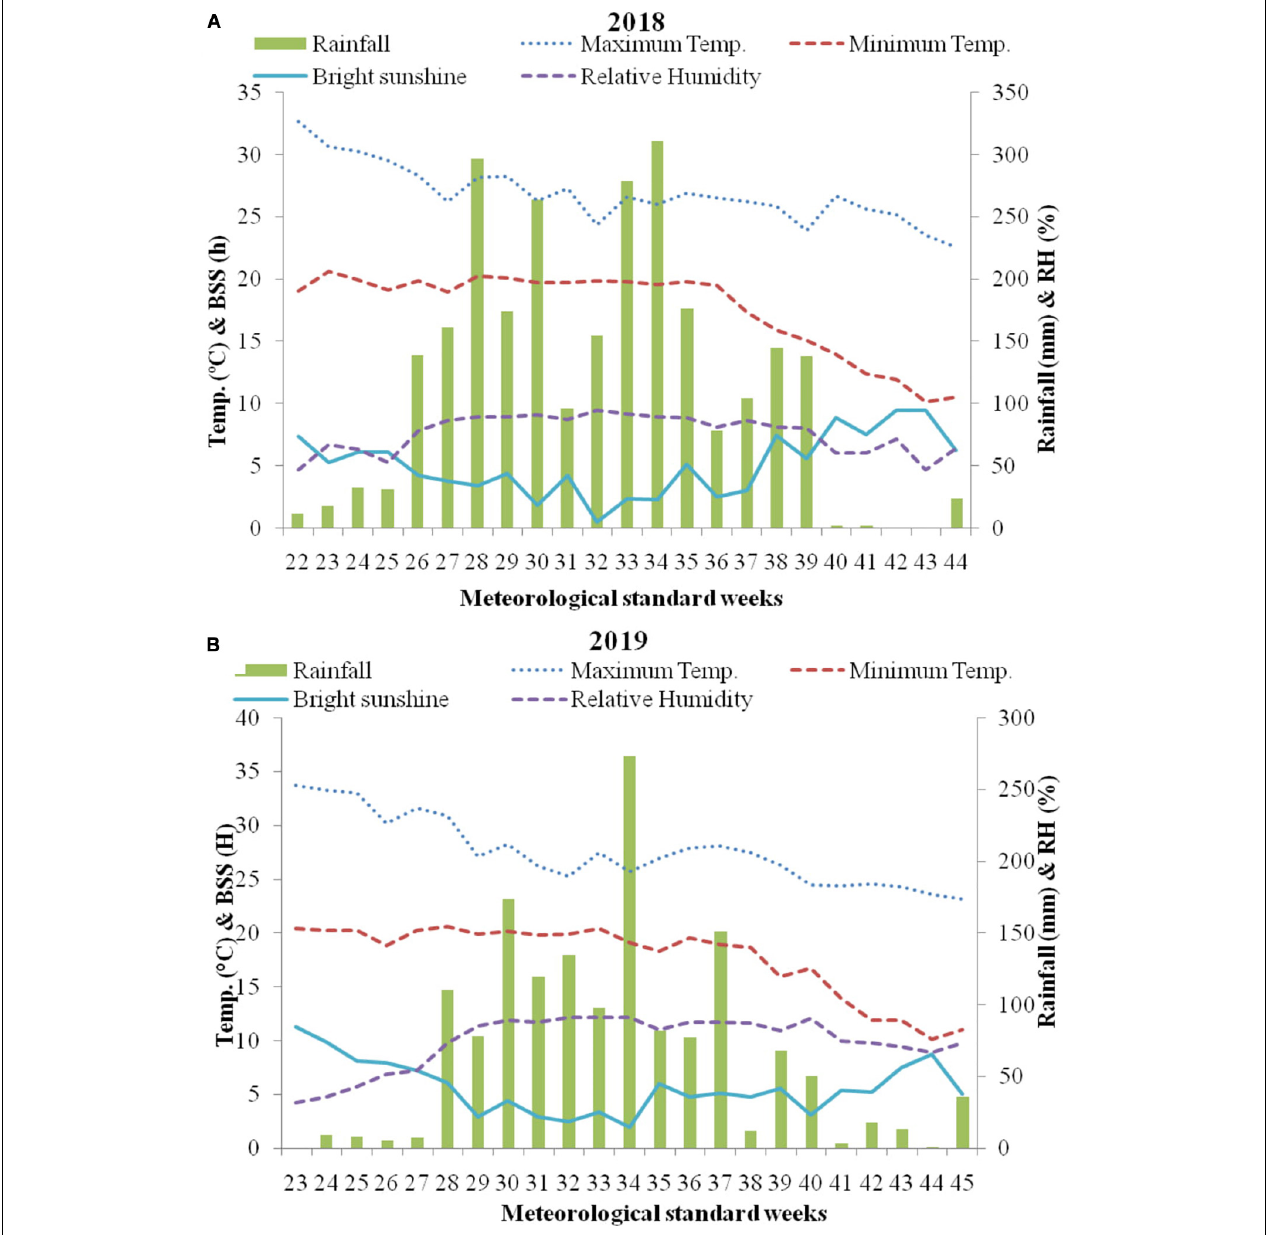
FIGURE 1 | Weekly mean climatological data (temperature, rainfall, sunshine hours, and relative humidity) during the growing season (A) 2018 and (B) 2019 at Palampur, India. BSS, Bright sunshine hours; RH, Relative humidity.